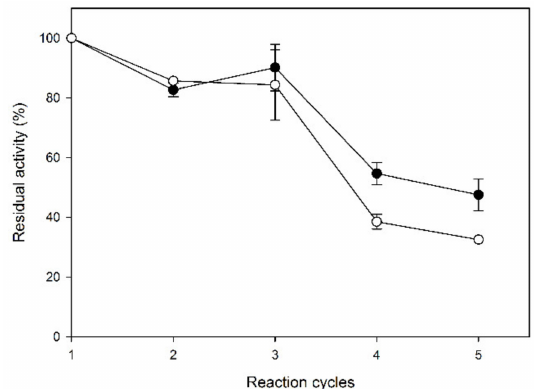
Figure 6. Operational stability of laccase-CLEAs in batches of 8-h reactions of OOMW removal. Black circles: CLEAs were washed between cycles, and white circles: CLEAs were used without